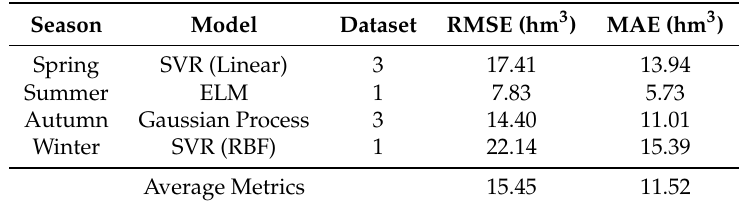
Table 6. Best results obtained for the case of temporal partitioning. Only the best algorithm in each season and dataset are detailed in this table.